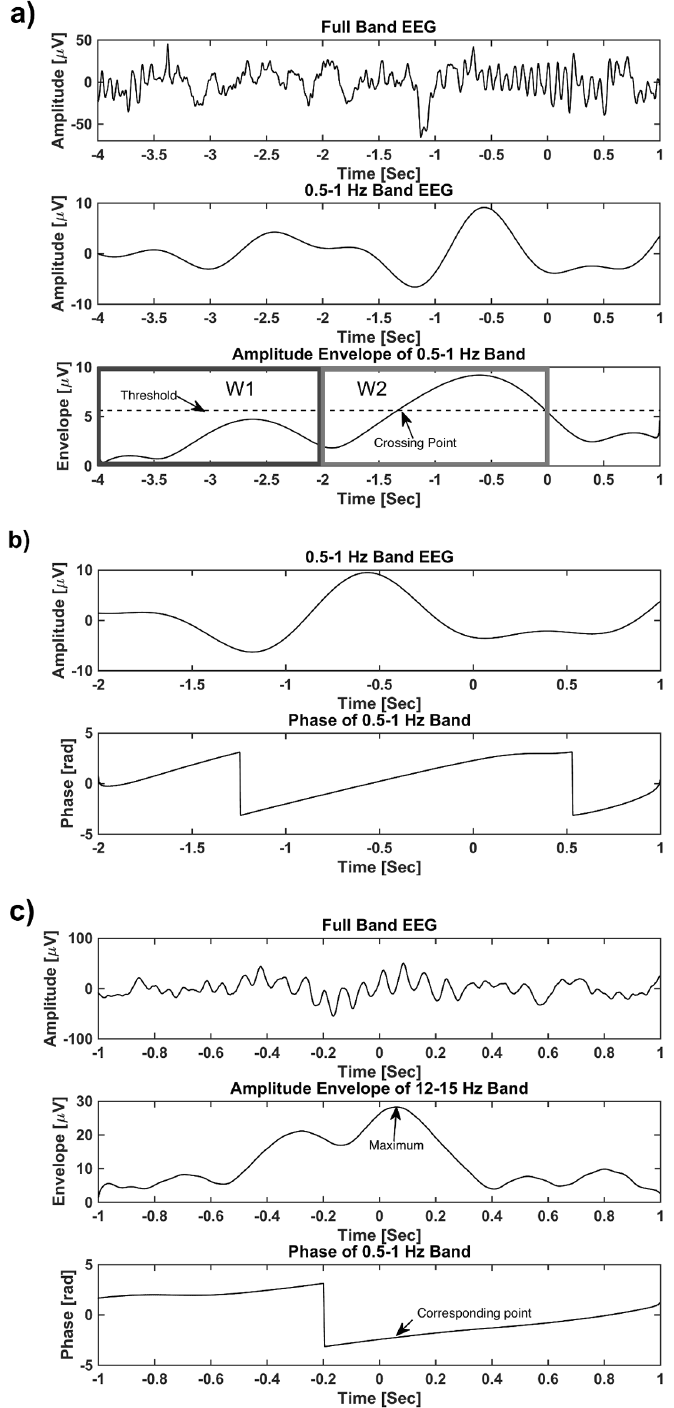
Fig 1. ( a ): Identification of spindle/SO complexes. Mean, μ , and standard deviation, σ , of the amplitude envelope of slow oscillations is calculated via the Hilbert transform in the reference window (W1) to build a threshold as T = μ +2 * σ . Then the amplitude envelope of slow oscillations was measured in a pre-spindle window (W2) to determine the presence of above-threshold slow oscillations that occurred prior to the spindle. ( b ): Phase of a sample signal in 0.5 – 1 Hz frequency band. ( c ): Phase of slow oscillations, provided by Hilbert transform, at the maximum of the spindle amplitude